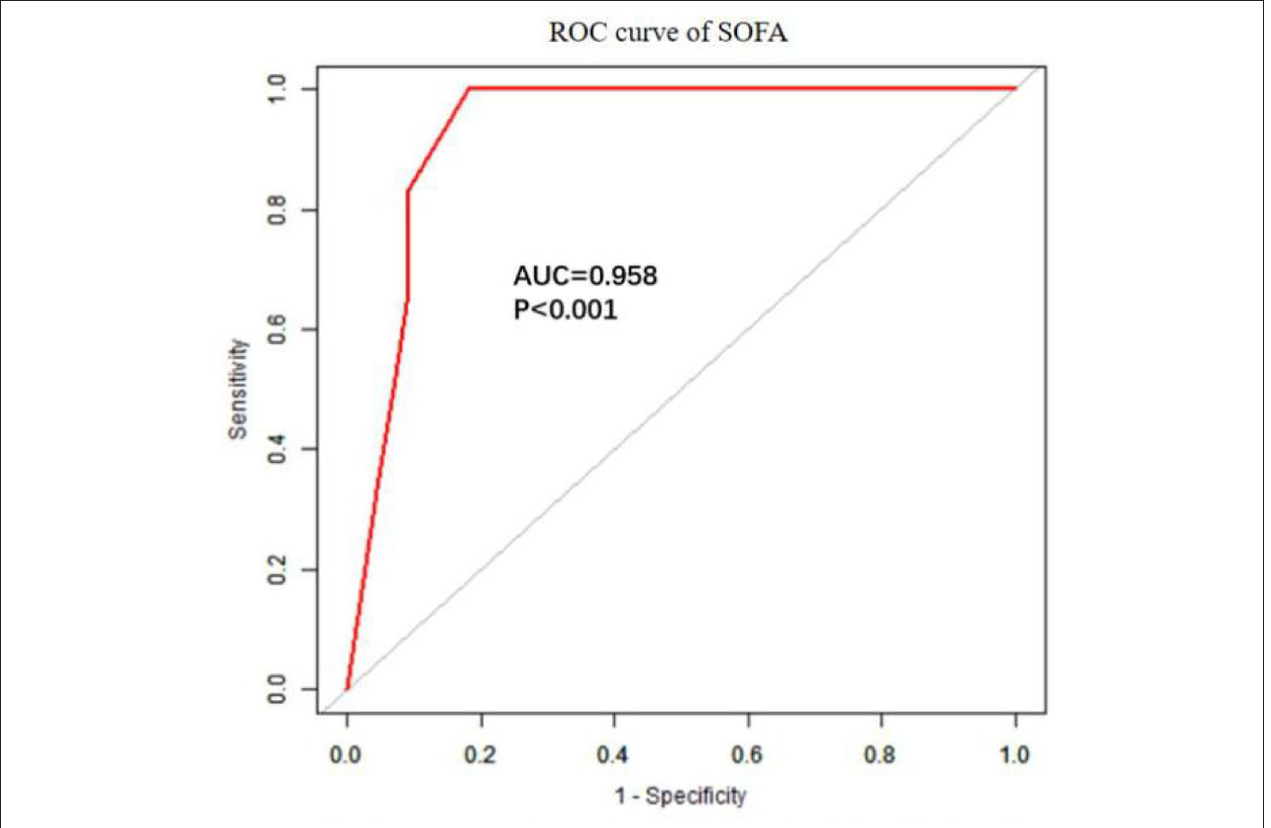
FIGURE 2 | The ROC curve of SOFA in predicting 90-day mortality with patients with RM induced by EHS. EHS, exertional heat stroke; RM, rhabdomyolysis; ROC, receiver operating characteristic; SOFA, Sequential Organ Failure